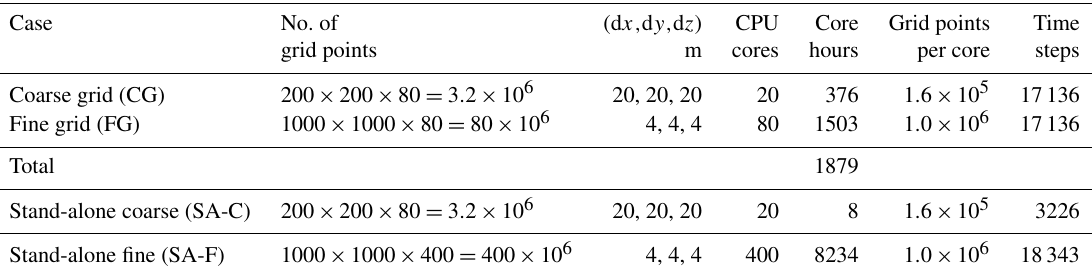
Table 3. Grid configuration of the nested and stand-alone reference domains.